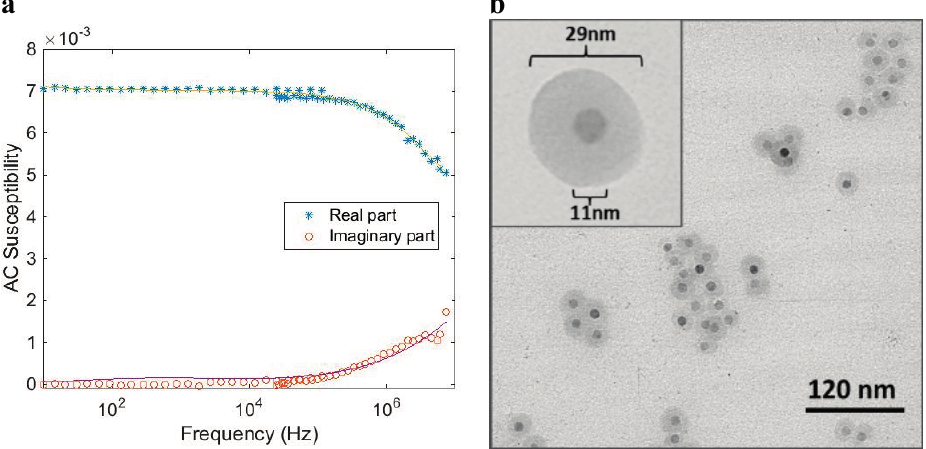
Figure 5. ( a ) AC (dynamical) susceptibility vs. frequency at room temperature of